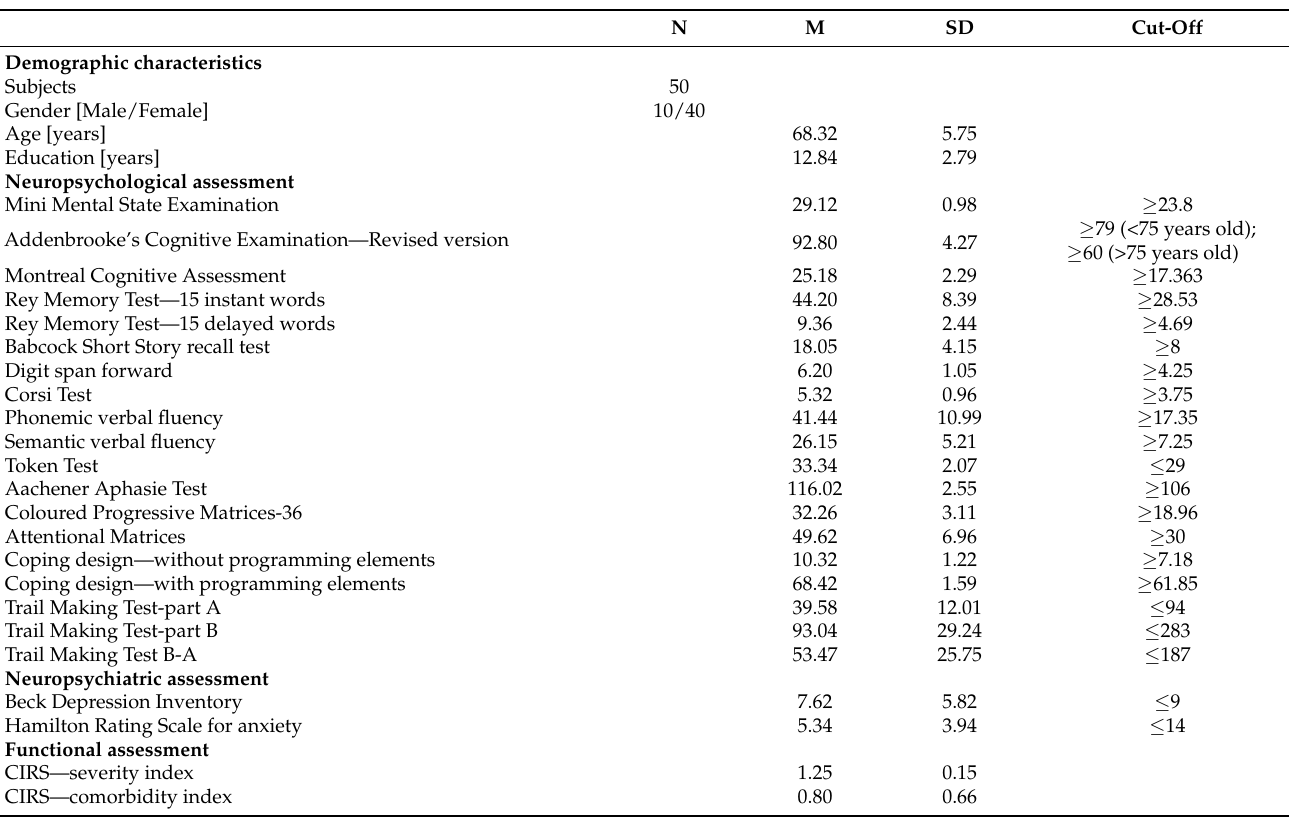
Table 1. Demographic and neuropsychological characteristics (T0).